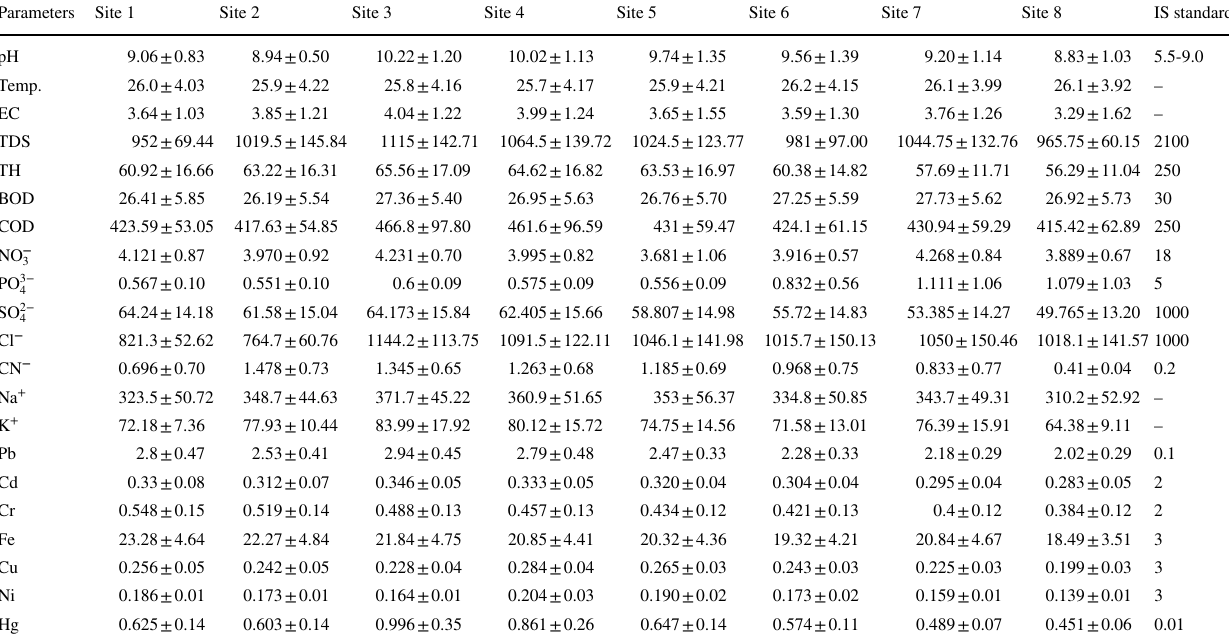
Table 2 Spatial characteristics of physicochemical parameters and heavy metal concentrations in stream water samples